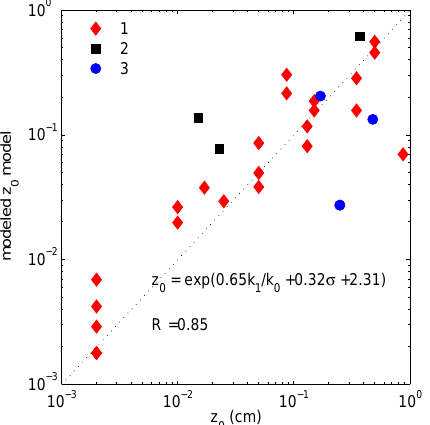
Fig. 5. Scatter plot of the modeled z 0 estimates using ASCAT and PARASOL simultaneously, versus the in situ z 0 values reported in (1) Marticorena et al. (2004), (2) Greeley et al. (1997), and (3) Marticorena et al. (2006).